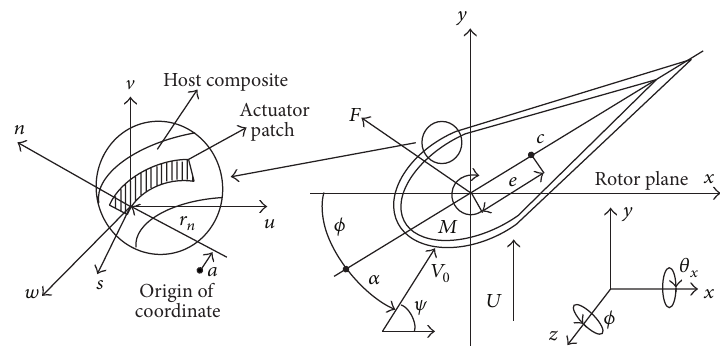
Figure 1: Coordinate system and aerodynamics and